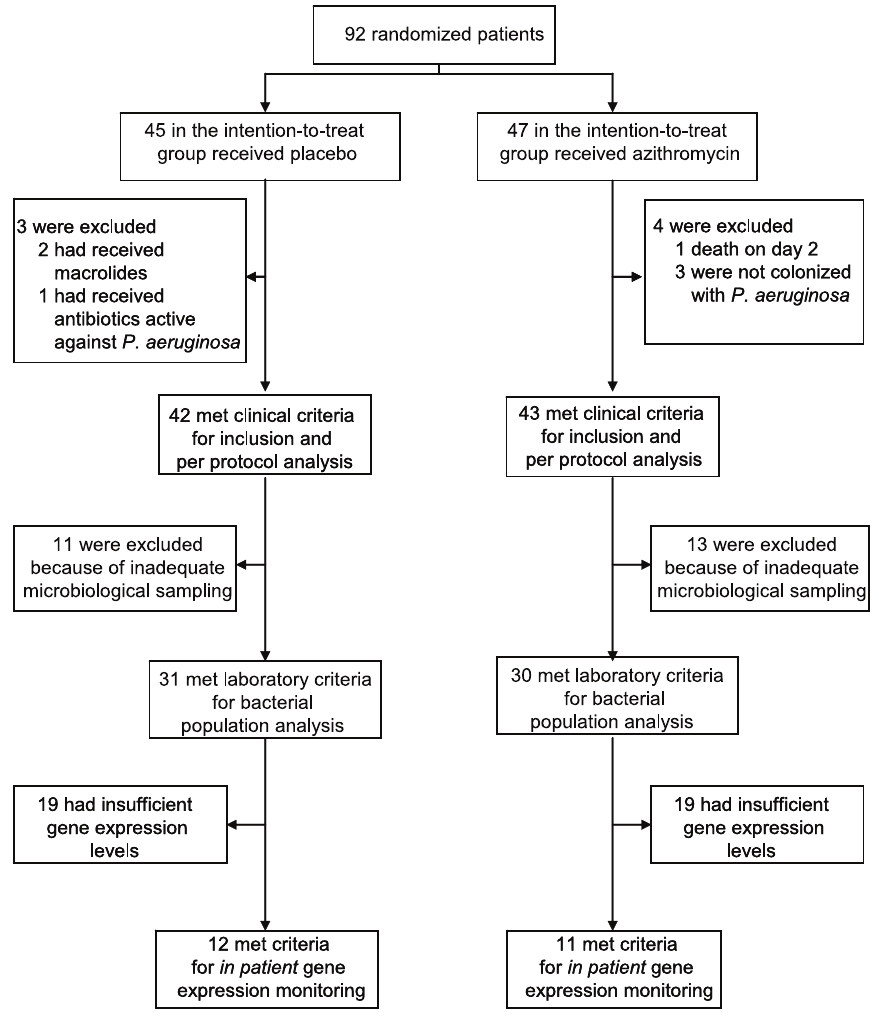
Figure 1. Patient enrollment and follow-up.